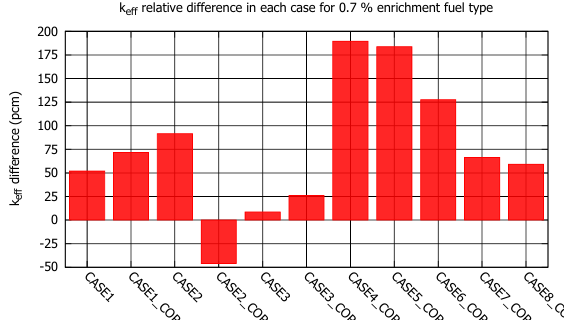
Figure 2. Relative eigenvalue differences in the cal-